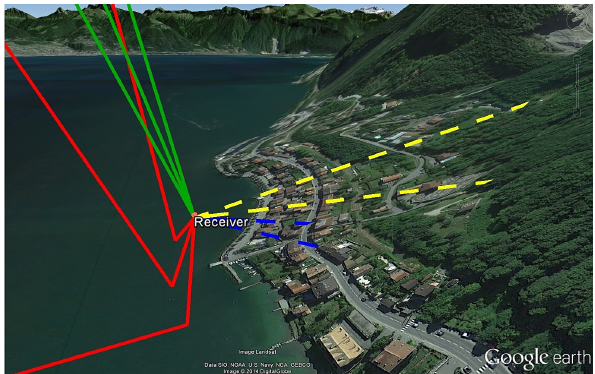
Figure 15. Influence of the topography – direct and reflected waves are displayed (topography amplified by a factor of 3). Yellow lines: direct waves, sphere approximation algorithm; green lines: direct waves, taking a DEM into account; blue lines: reflected waves, sphere approximation algorithm; red lines: reflected waves, taking a DEM into account. It can be noticed that some yellow and blue lines (direct and reflected waves, sphere approximation algorithm) go through the mountain (reflection points having been calculated inside the mountain), whereas any red or green lines (direct and re- flected waves, integrating a DEM) go through